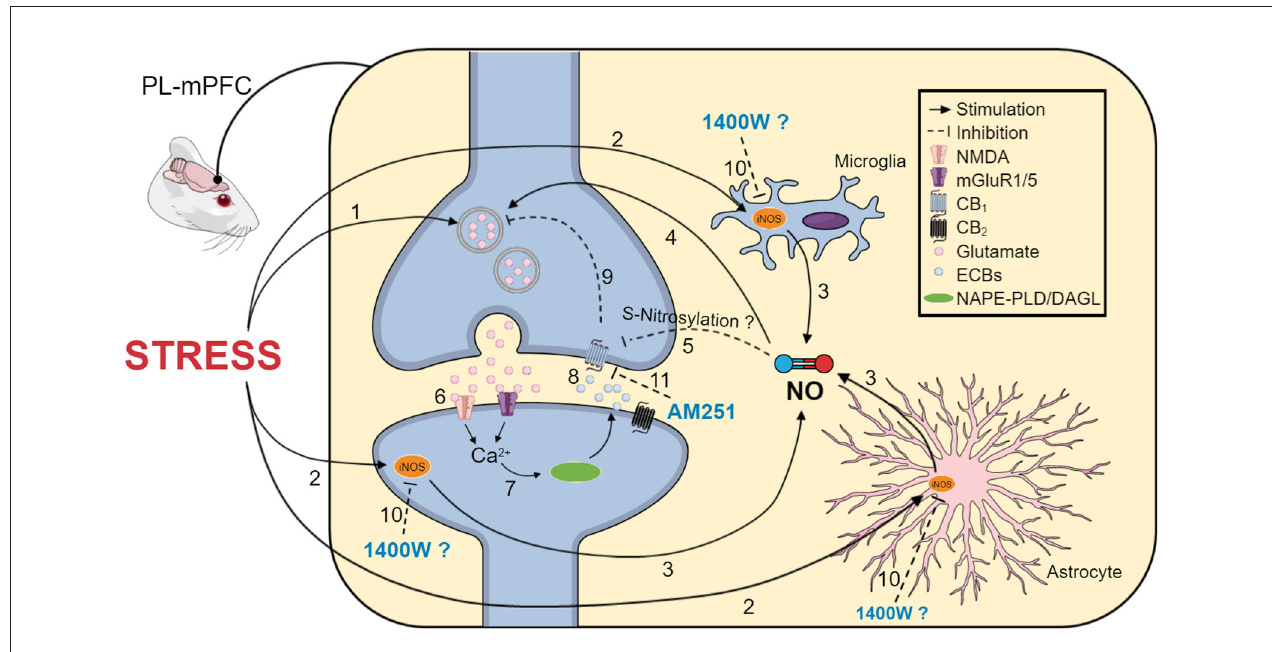
FIGURE 5 | Schematic representation of the proposed mechanisms involved in the anti-stress effect of 1400W in the PL-mPFC. (1) Acute stress induces glutamate release (2) and activates iNOS, which could be expressed in microglia, astrocytes, and neurons. (3) Increased iNOS activity increases NO levels, (4) which can potentiate glutamatergic transmission. (5) NO may promote protein S-nitrosylation, including the CB 1 receptor. Therefore, it could inhibit its function, impairing neurotransmission control. (6) Glutamate also activates mGlu5 and NMDA receptors, increasing intracellular calcium levels, (7) resulting in activation of the ECB synthesizing enzymes, NAPE-PLD and DAGL-a, increasing ECB levels. (8) Anandamide and 2-AG could act on CB 1 / 2 receptors (9), regulating neuronal excitability. In the context of stress, NO could overcome ECBs’ stress-buffer actions, favoring the release of glutamate, excessive excitability, and anxiety-like behaviors. In this way, (10) iNOS inhibition by 1400W could attenuate this positive feedback in neurons and reduce inflammatory consequences of iNOS activation in glial cells. ECBs acting at CB receptors. The figure was simplified. Therefore, not all cells and components of synapses and glial cells are